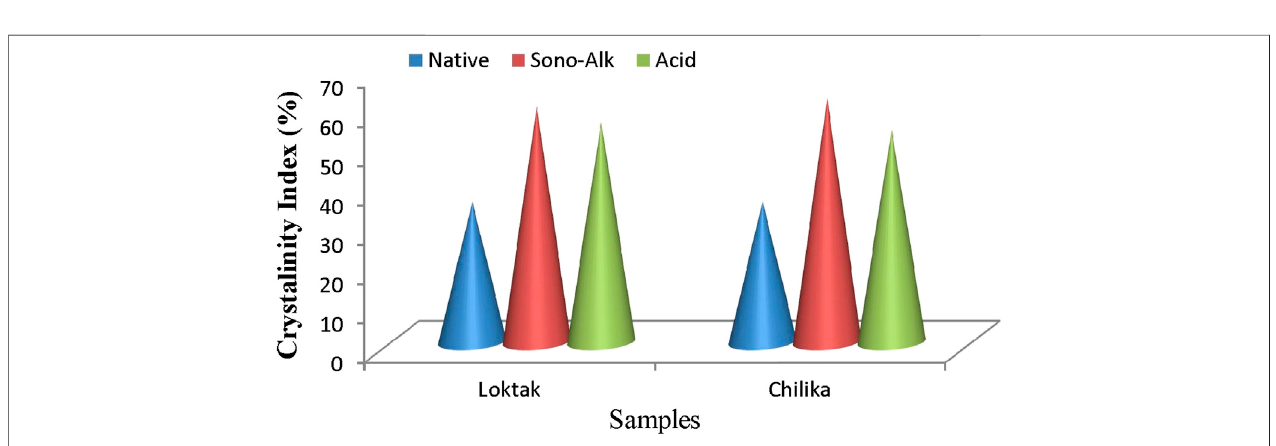
Frontiers in Energy Research |